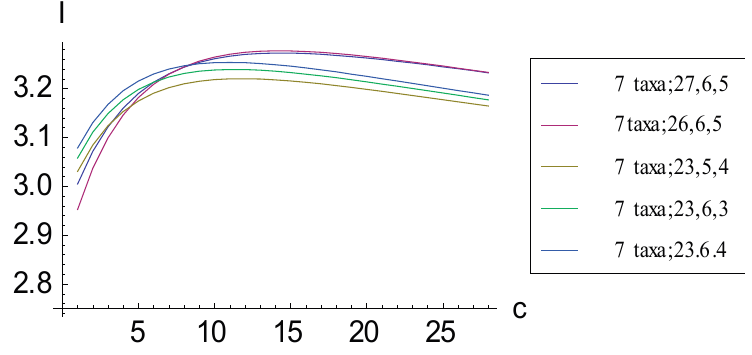
Figure 6. Plots relating information measure I and added autapomorphic characters c for some consistent basal matrices for seven taxa. The absolute maximum I is achieved by representation (7 taxa; 26, 6, 5) rather than by the representation corresponding to the pectinate consistent basal matrix (7 taxa; 27, 6, 5), which contains more 1s. After the absolute maximum has been achieved, plots descend in the order (7 taxa; 27, 6, 5), (7 taxa; 26, 6, 5), (7 taxa; 23, 6, 4), (7 taxa; 23, 6, 3), and (7 taxa; 23, 5, 4).